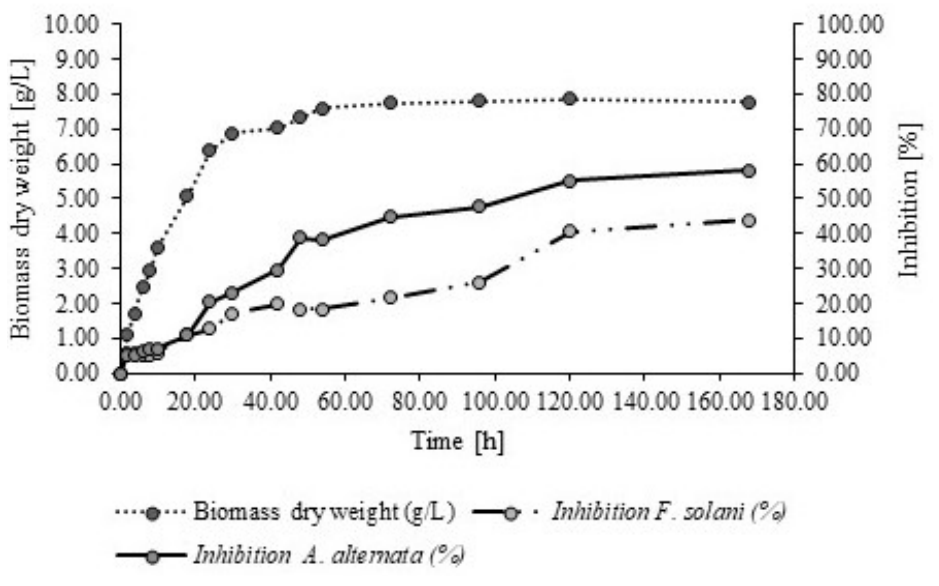
Figure 1. Growth kinetics of P. fluorescens and the antifungal effect of cell-free extracts of P. fluorescens on A. alternata and F. solani incubated for 168 h. Table 1. Evaluation of the antifungal effect of cell-free extracts of P. fluorescens on mycelial growth and the inhibition of A. alternata and F. solani .